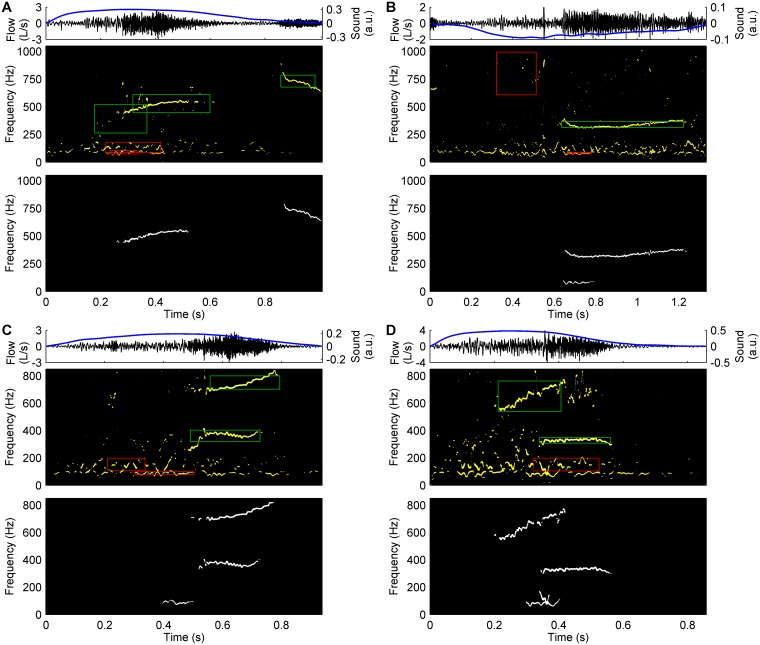
Segmentation of acoustic components from the Hilbert spectrum.For each subfigure: flow and respiratory sound signals of a respiratory cycle (top), the Hilbert spectrum of the respiratory sound signal (middle), and the acoustic components segmented using our acoustic component segmentation method [34] (bottom). In the Hilbert spectrums, CAS areas are plotted in green, and normal areas are plotted in red. A) Two inspiratory CAS components occurring at different times (multiple monophonic CAS). B) A single expiratory CAS component. C) D) Inspiratory CAS components overlapping in time (polyphonic CAS). Subfigures B, C, and D also show some low-pitched non-CAS components that correspond to normal respiratory sounds but are similar to CAS components, and therefore are segmented by our acoustic component segmentation method.